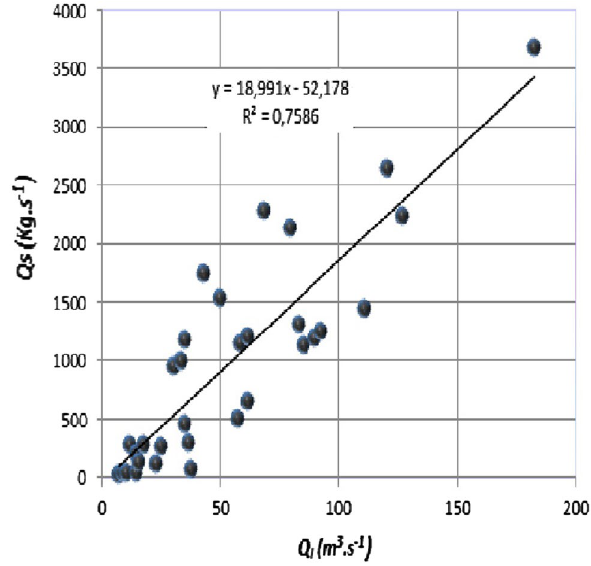
Fig. 4 Correlation of maximum solid flow as a function of maximum liquid flow